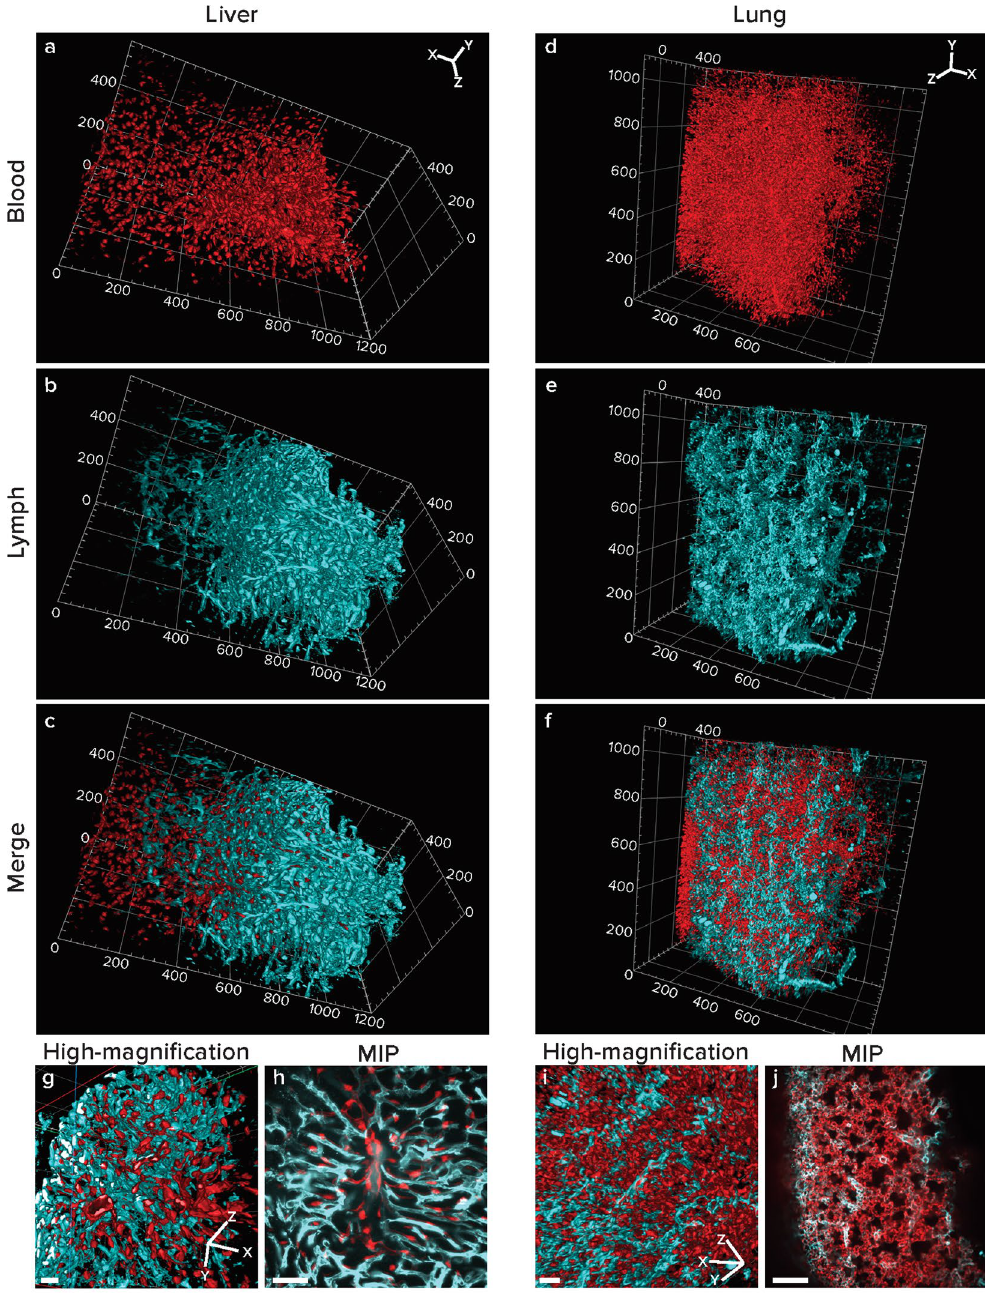
Figure 2. Three-dimensional reconstruction and MIP of slabs for liver and lung. Livers and lungs were harvested from Vecad cre /tdTomato flox/stop/flox transgenic mice (blood vessels, red channel) and were labeled with LYVE1 antibody (lymphatic vessels, cyan channel). Organs were cleared and imaged using a light-sheet fluorescent microscope. Imaging was done using dual side illumination and fused (single side illumination is presented in Supplementary Figure 1). Data sets of liver ( a – c ) and lung ( d – f ) are presented as 3D volumes. Maximal intensity projections (MIP) of slabs (liver: 30 slices/23.1 μ m, lung: 3 slices/4.86 µ m) show the structure of an hepatic lobule with its mid central vein ( g ) and lung lobules surrounded by vasculature( j ). High-magnification of rotated images ( g , i ) show the continuity of blood and lymphatic vessels. Scale